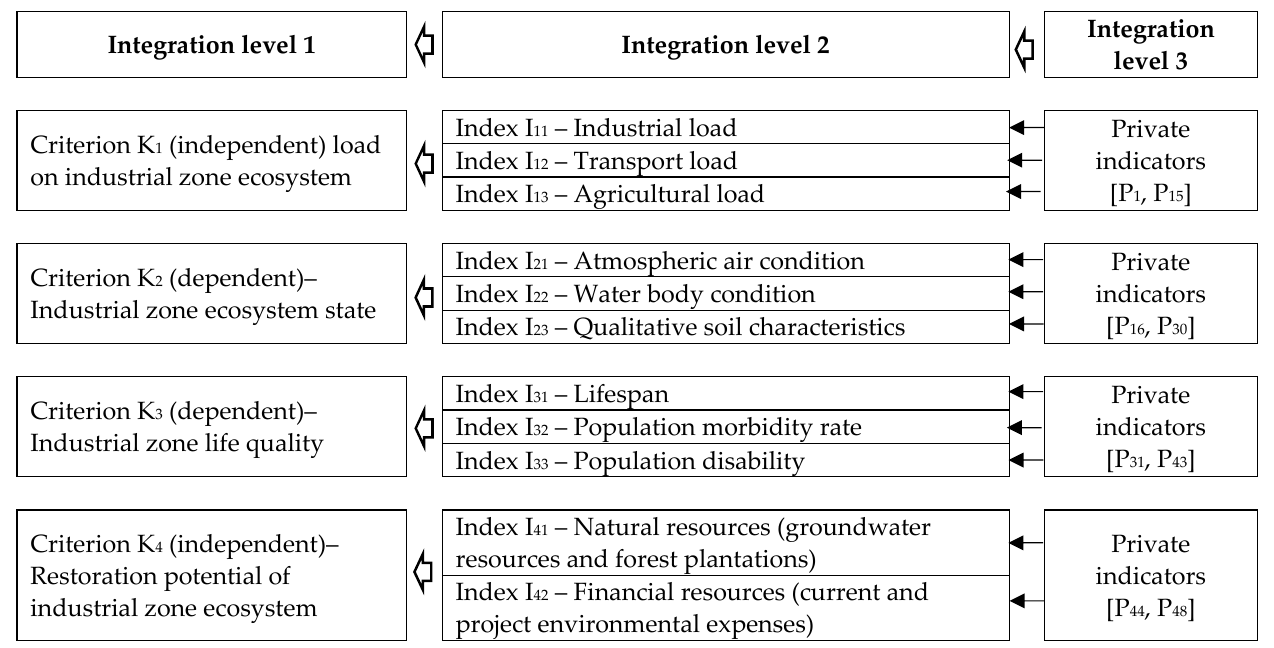
Figure 2. Multi-criteria three-level system for environmental sustainability of chemical production development zones assessment.